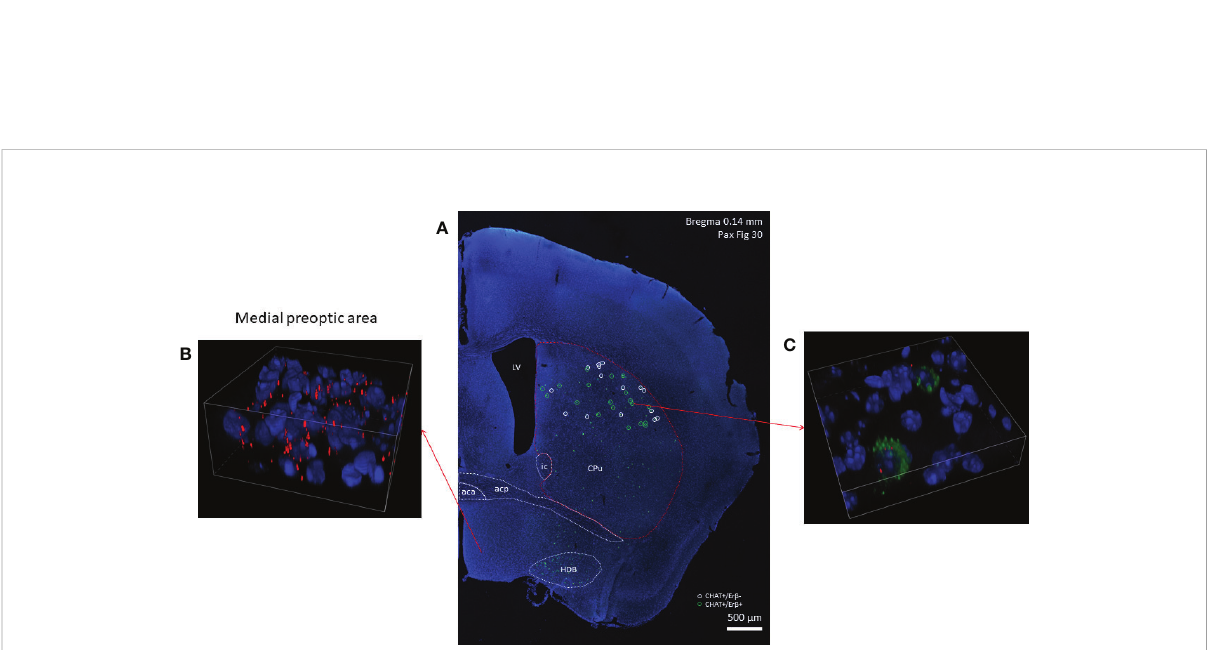
FIGURE 4 Estrogen receptor beta mRNA expression in striatal cholinergic neurons. CHAT mRNA-positive cells showing green fl uorescence labeling in the right side of a coronal section are depicted in Panel (A) (10x). In the dorsal striatum white and green circles mark ER b -negative and ER b -positive cholinergic interneurons, respectively. Cells with high ER b mRNA expression in the medial preoptic area are presented in Panel (B) Representative confocal image shows the expression of ER b mRNA in 2 cholinergic interneurons in the dorsal striatum (blue: nuclei, green: CHAT mRNA, red: ER a mRNA, 60x) (Panel C ). CPu, caudate-putamen; aca, anterior limb of anterior commissure; acp, posterior limb of anterior commissure; HDB, horizontal limb of the diagonal band of Broca; LV, lateral